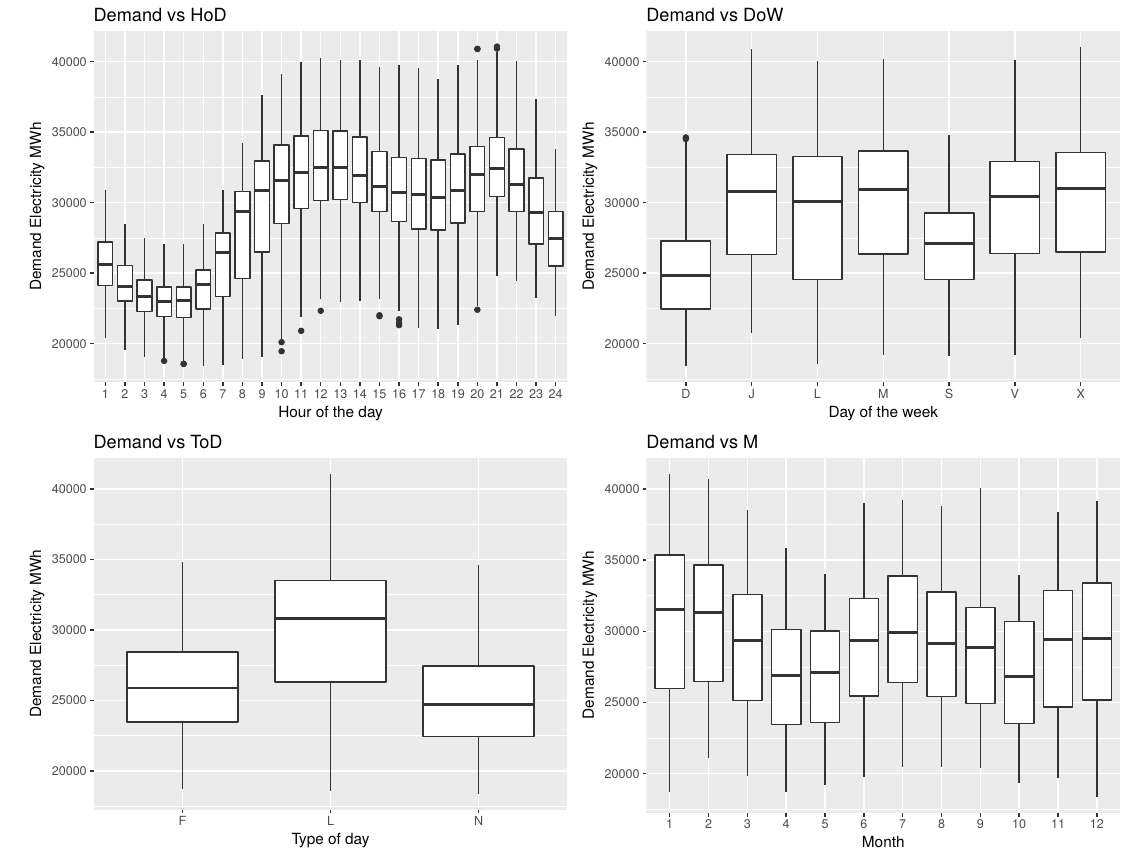
Figure 13. Boxplot Demand vs. HoD, DoW, ToD and M. Public source: www.esios.ree.es.